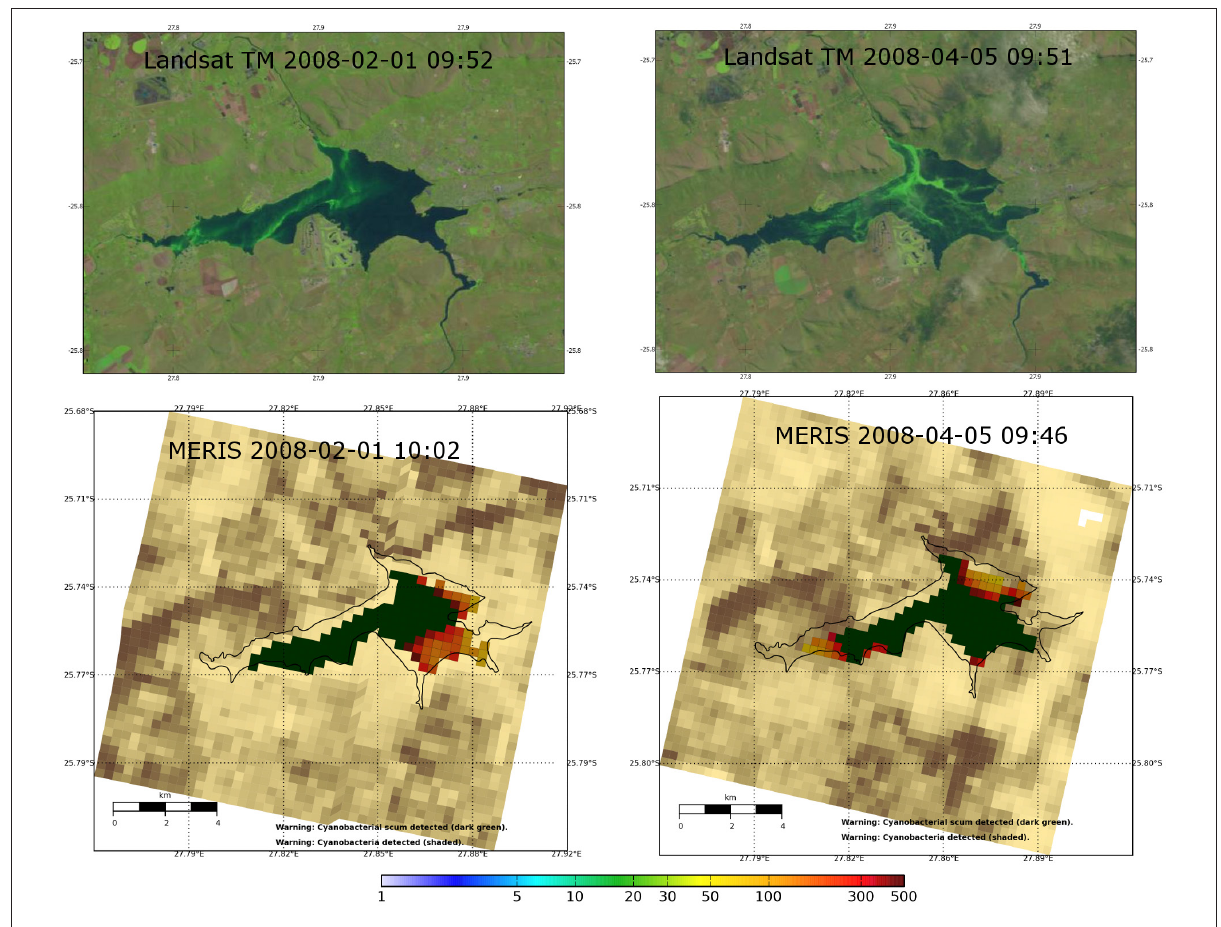
Figure 4: Surface scum maps of Hartbeespoort Dam from simultaneously acquired MERIS and Landsat imagery. Dark-green pixels correspond to surface scum in the MERIS imagery.